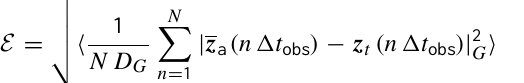
Fig. 4. Top: Imbalance ¯ B of the analysis as a function of anal- ysis cycles for ∆ t obs = 5 . 5 hrs in a log -plot. In order of in- creasing values of ¯ B are VLKF- B (magenta open circles), IAU (black crosses) VLKF- ˙ h (cyan squares), DEnKF (blue diamonds) and EnKF (red crosses). Bottom: Temporally averaged imbalance ¯ B ( n ∆ t h ¯ Bi = 1 P N obs ) of the analysis as a function of the ob- n =1 N servation interval ∆ t obs .